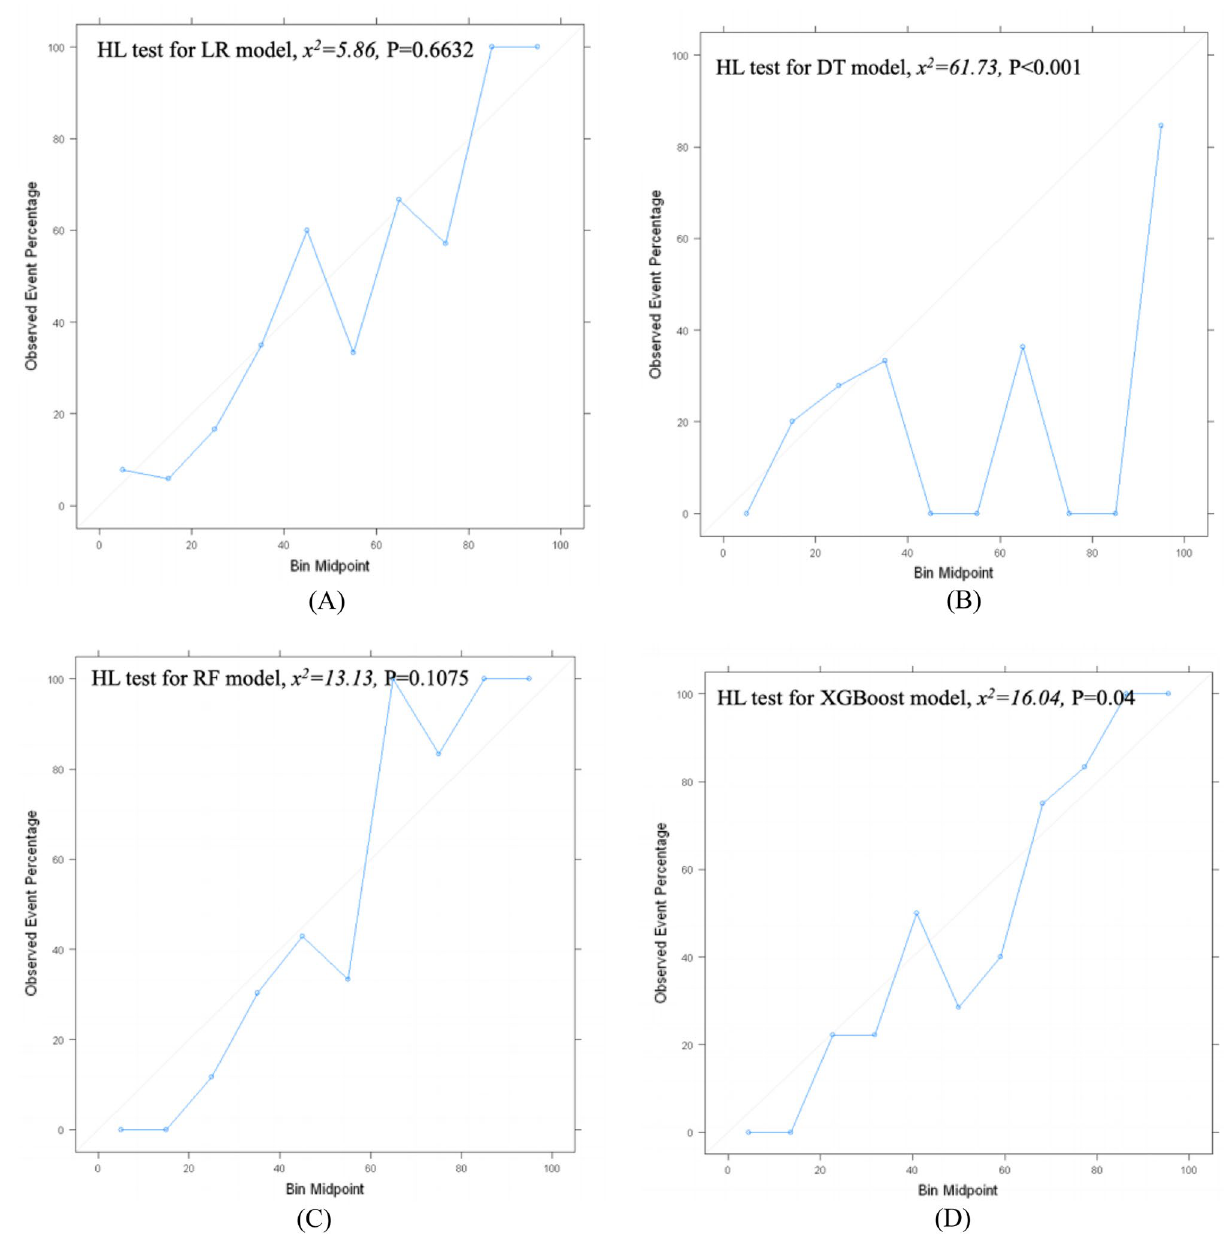
Figure 5. Calibration curve and HL-test result of machine learning models of testing set. ( A ) for logistic regression, ( B ) for decision tree, ( C ) for random forest, ( D ) for XGBoost, ( E ) for neural network, ( F ) for naïve bayes, ( G ) for support vector